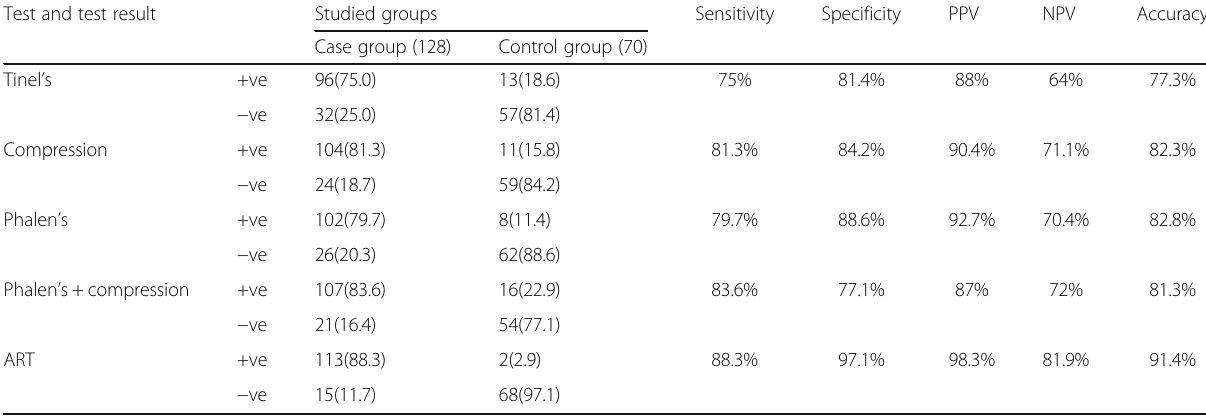
Table 2 Preoperative provocative tests results among case and control groups Test and test result Studied groups